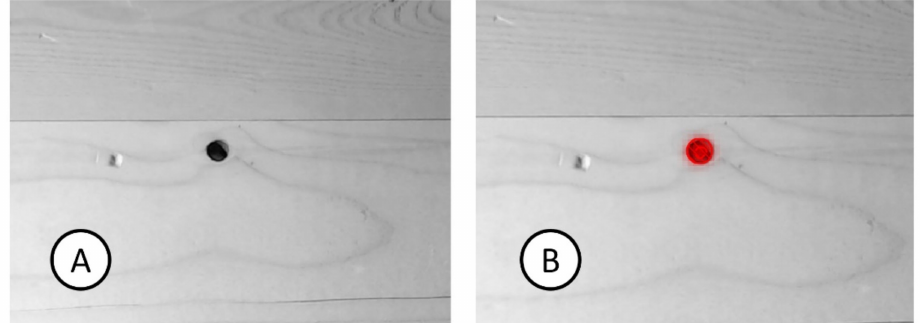
Figure 10. This figure shows a wood surface with a knot hole. An unprocessed picture is shown in ( A , B ) shows a processed picture where the knot hole has been detected and a heatmap has been applied, by the program, to highlight the detected